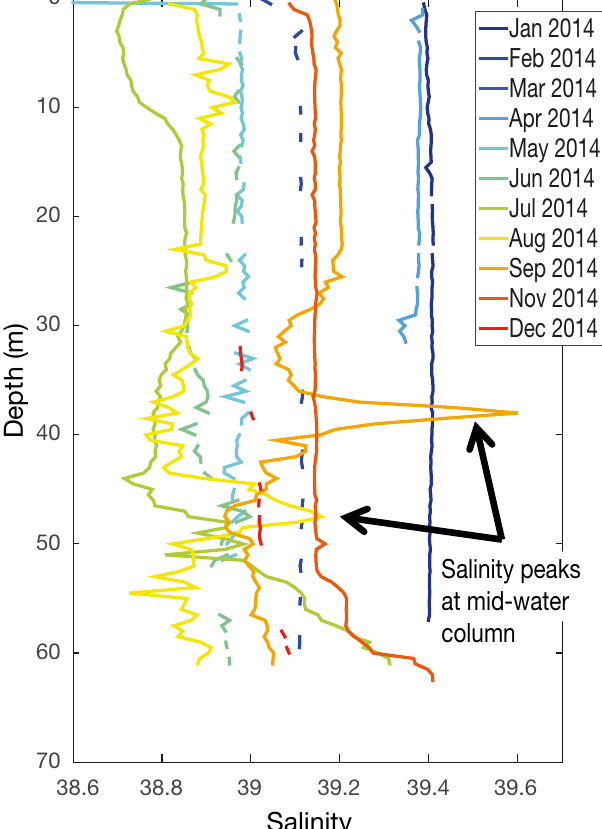
Fig. 7. Salinity profiles at Stn NW (see Fig. 1) during monthly surveys from January to December 2014. Arrows